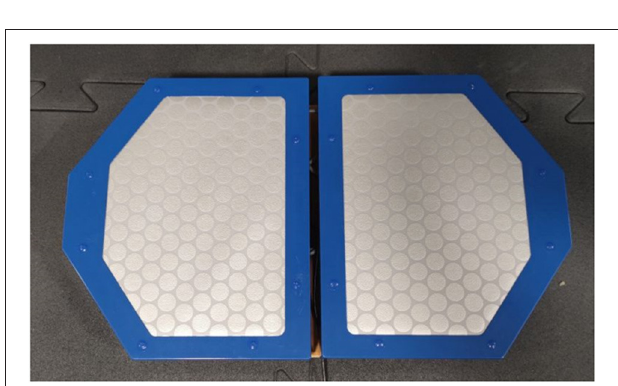
and image distortion software. It provides the user a smooth, high-resolution 3D view, showing the spatial situation outside the cockpit with the 49 degrees vertical and 208 degrees horizontal field of view